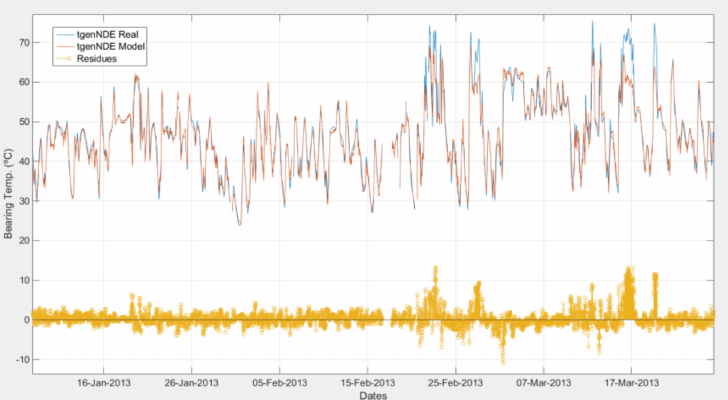
Figure 14. NDE bearing temperature (in blue), Generic Model estimation (in red) and residues (yellow) just before the bearing